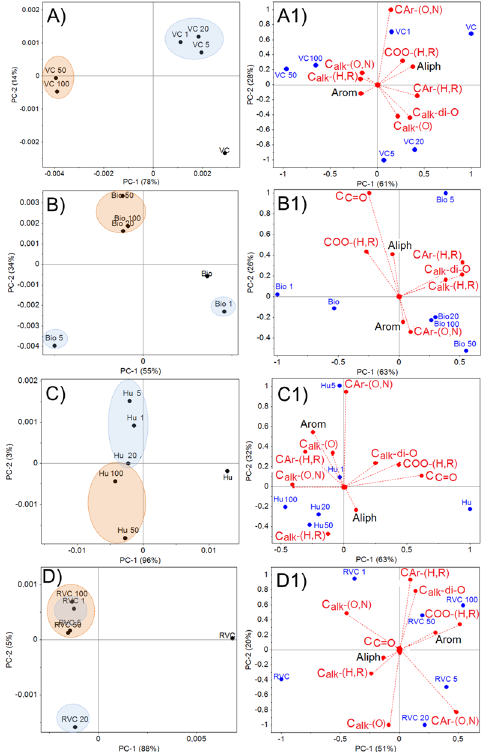
Fig 3. PCA Analysis of CP/MAS 13 C-NMR Pure Spectra (A, B, C, D and E) and the Carbon Type (A1, B1, C1, D1 and E1) of Materials with and without Various Levels of Retained Cd 2+